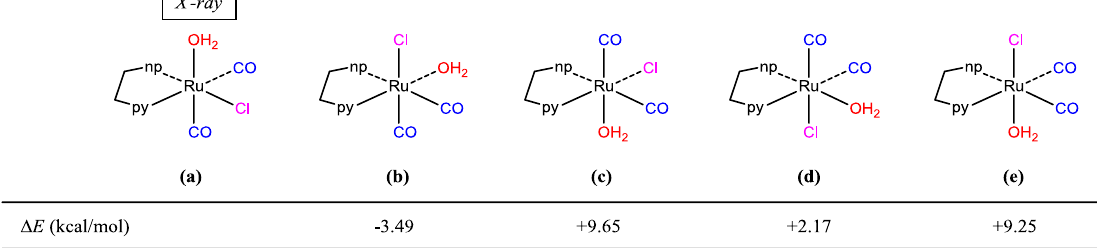
Figure 2. Possible geometrical isomers of cis (CO)-[Ru(pynp)(CO) 2 (OH 2 )Cl] + with their electronic energy differences versus configuration ( a ). np and py denote 1,8-naphthyridyl and pyridyl rings, respectively.